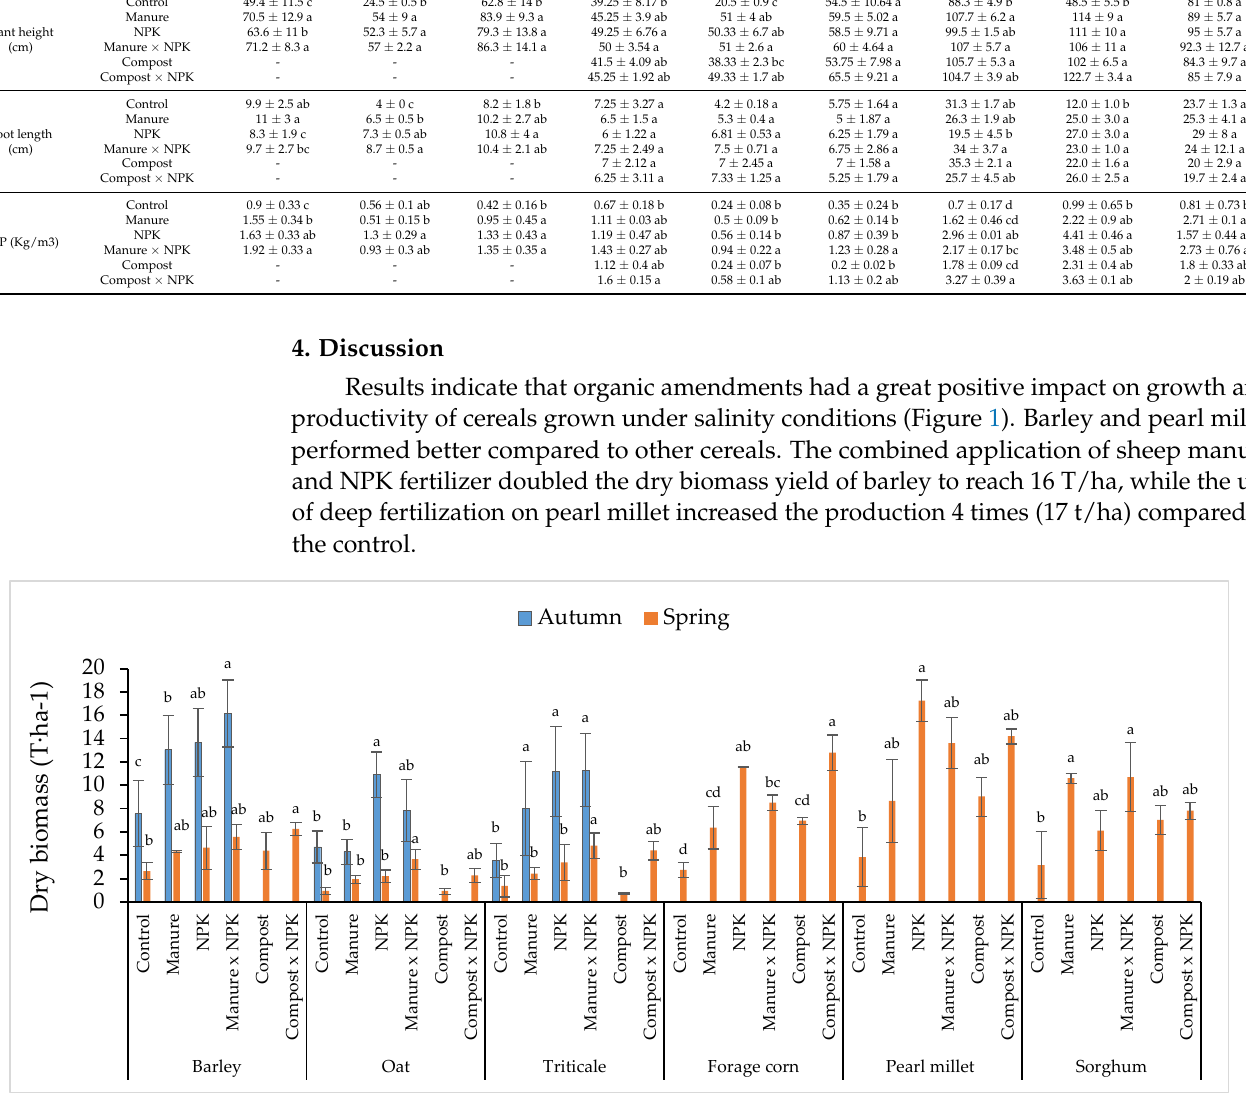
Figure 1. Total dry matter yield of different cereals as affected by different organic and inorganic amendments. Means sharing same letters do not differ significantly at p = 0.05. Vertical lines indicate the standard